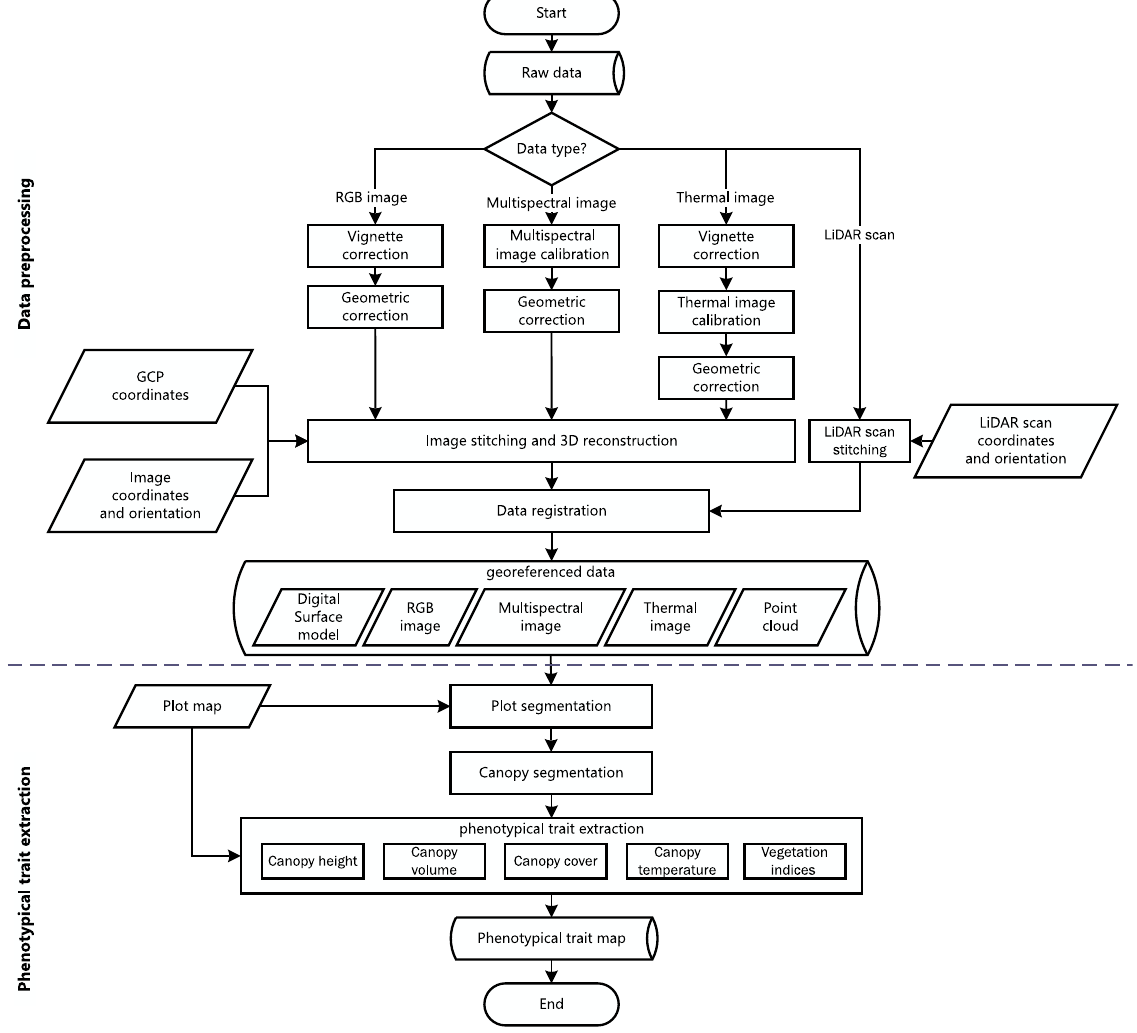
Figure 6. Overall data processing